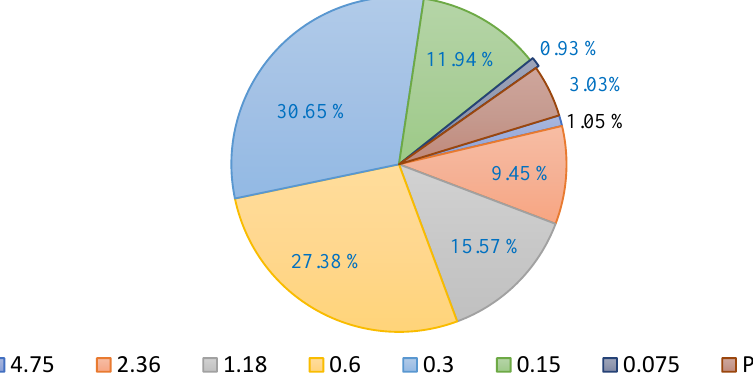
Figure 3. Percentage of natural river sand retained in individual sieves.